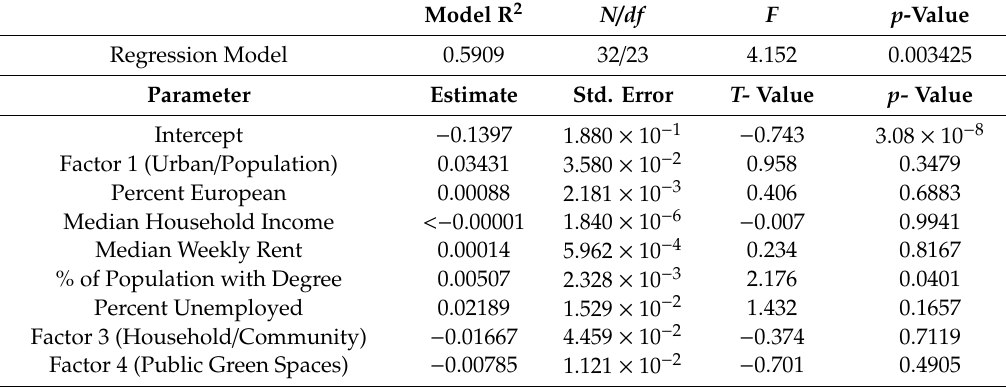
Table 9. Results of the multiple regression analysis predicting excellent QoUL from the five Factor 2 variables and three factors.